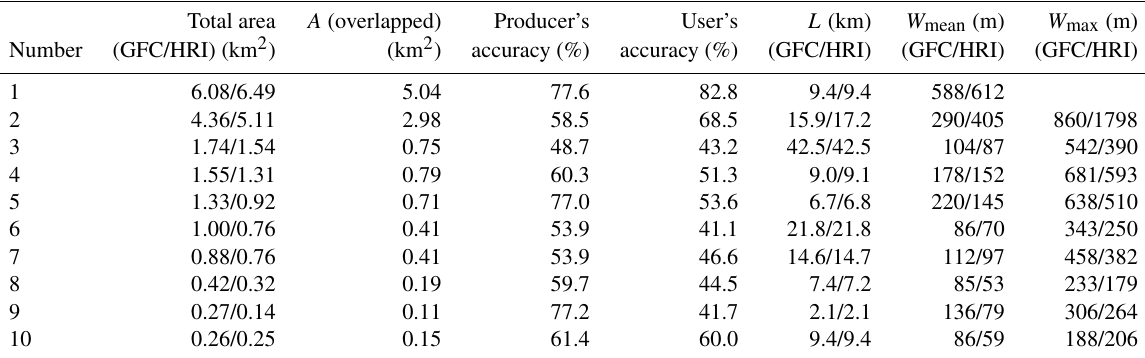
Figure 8. Overlapping of windthrow areas extracted from the GFC dataset and delineated manually using the HRIs for (a) a convective- storm-induced windthrow (18 July 2012) and (b) a tornado-induced windthrow (June 2011). Table 5. Comparison of windthrow geometrical parameters estimated using the GFC and HRI